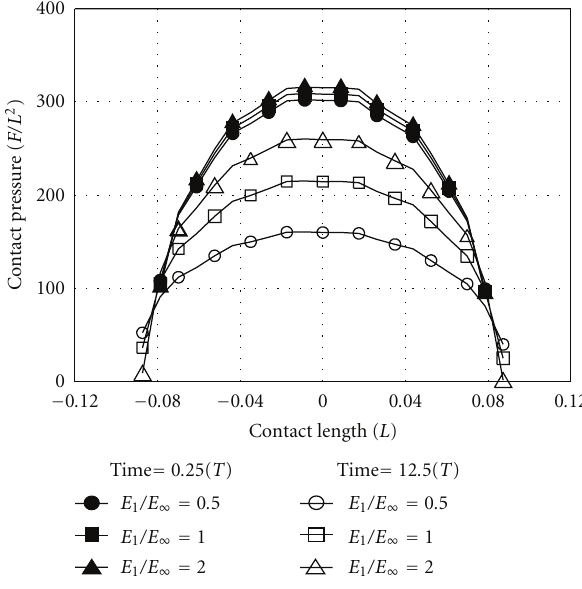
Figure 10: E ff ect of E 1 /E ∞ on the contact pressure